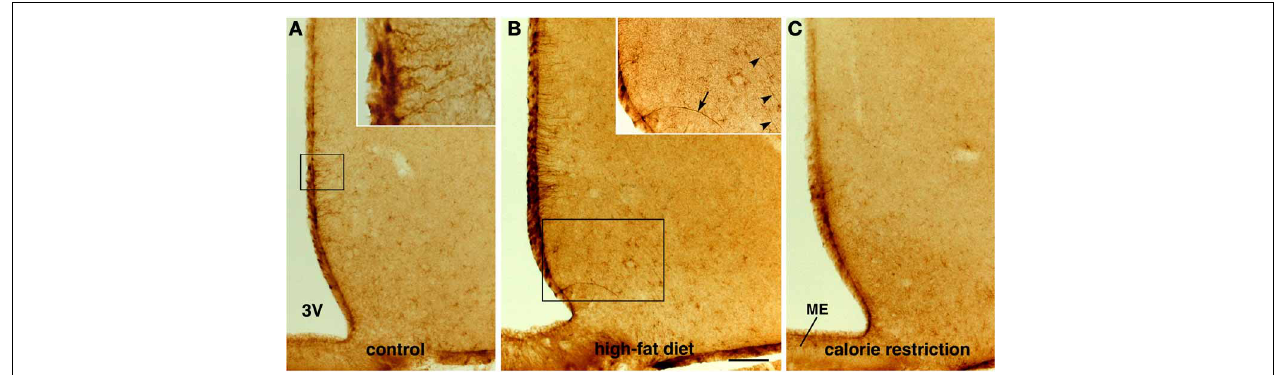
FIGURE 3 | Immunohistochemical detection of CNTF in the mouse tuberal hypothalamus. Some CNTF-stained tanycytes on the ventrolateral wall of the third ventricle (3V) in control mouse (A) . In an HFD mouse (B) , strongly increased CNTF staining of tanycytes also results in more (inset of B , arrow) or less (inset of B ,